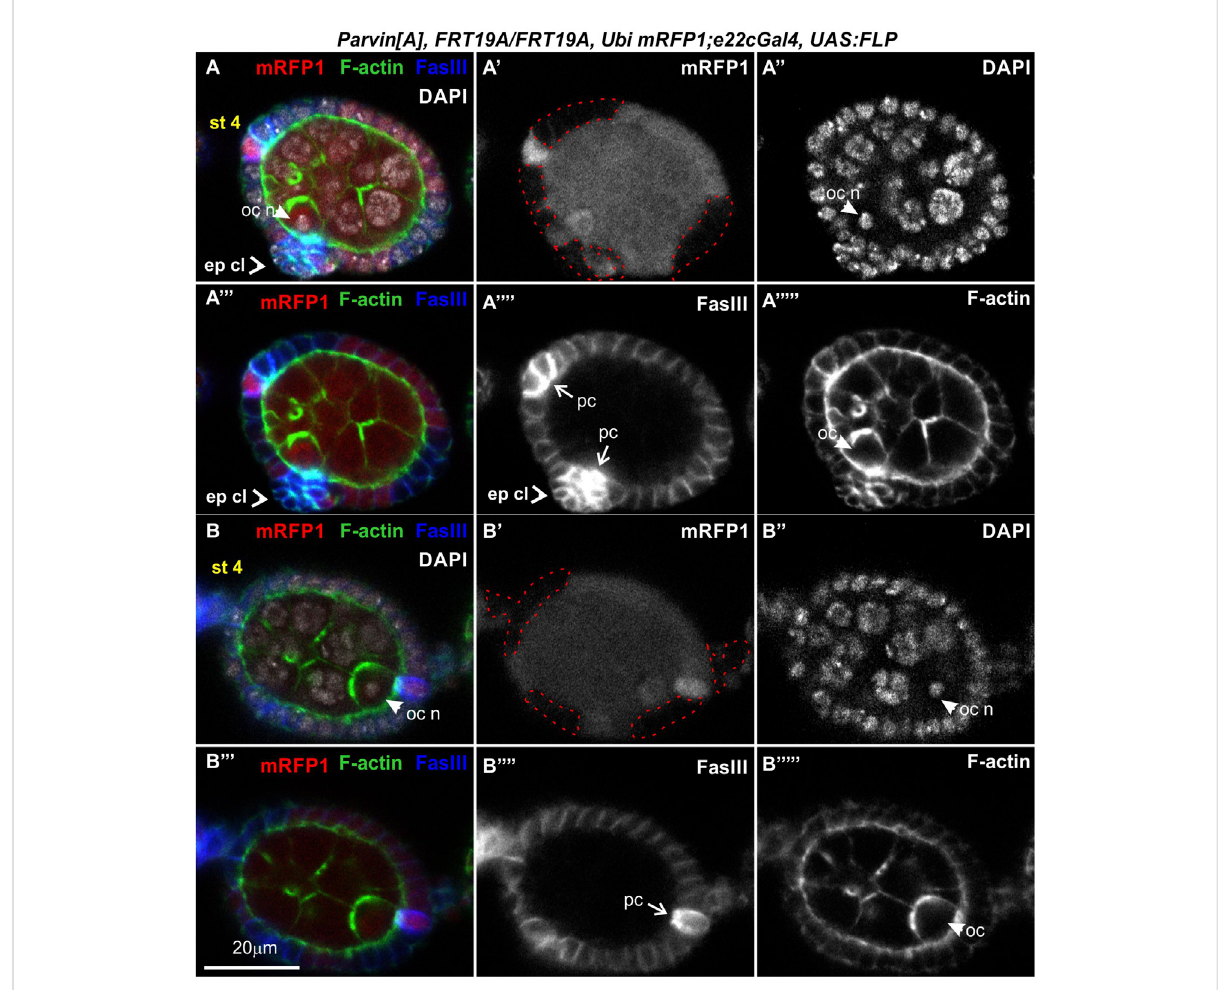
FIGURE 9 Genetic mosaics for Parvin generated with e22cGal4 lead to epithelial clusters and fused egg chambers. (A-B - ’’ ) Confocal micrographs of a stage 4 egg chamber derived from Parvin A mosaic fl ies generated by e22cGal4 . Co-staining with FasIII and F-actin labels the periphery of follicle epithelial cells. (A,B) A compound egg chamber at different optical cross sections encircled by mutant cells for Parvin . (A 9 ,B 9 ) Parvin A mutant cells were marked by the absence of mRFP1 and are highlighted with a red dashed line. (A-A - ’’ ) Protruding epithelial clusters in the middle region of the compound egg chamber characterized by elevated FasIII protein levels. (A 9 ,A - ’ ) The anterior polar cells are located in the same focal plane with the protruding epithelial cluster. The oocyte nucleus of the younger cyst is localized laterally of the epithelial protruding cells. (A") The oocyte nucleus of the younger cyst is located laterally of the epithelial protruding cell cluster. (B-B - ’’ ) The oocyte nucleus of the older cyst is located in (B 9 ) theposteriorendandinclosecontactwith (B - ’ ) theposteriorlylocatedpolarcells.epcl,epithelialcluster;oc,oocyte;ocn,oocytenucleus;pc,polar cells. Scale bars: 20 μ m in all